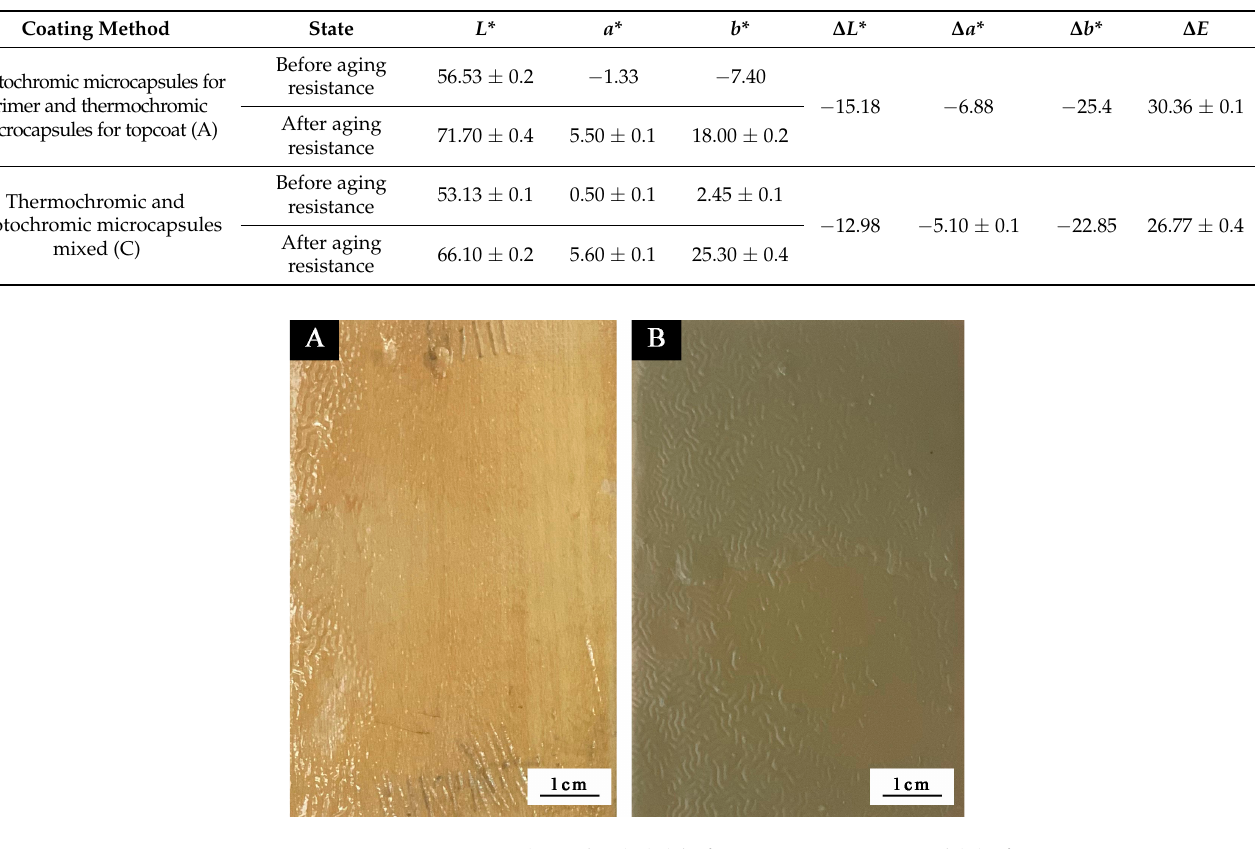
Table 13. Color difference of coating before and after aging under different coating processes.